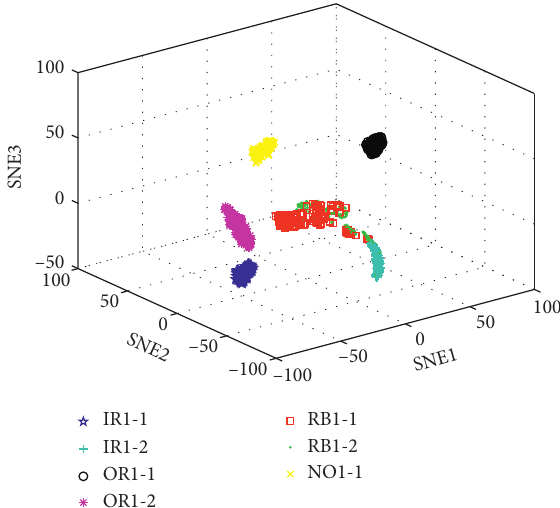
Figure 10: Feature visualization map of DCSAE in experiment